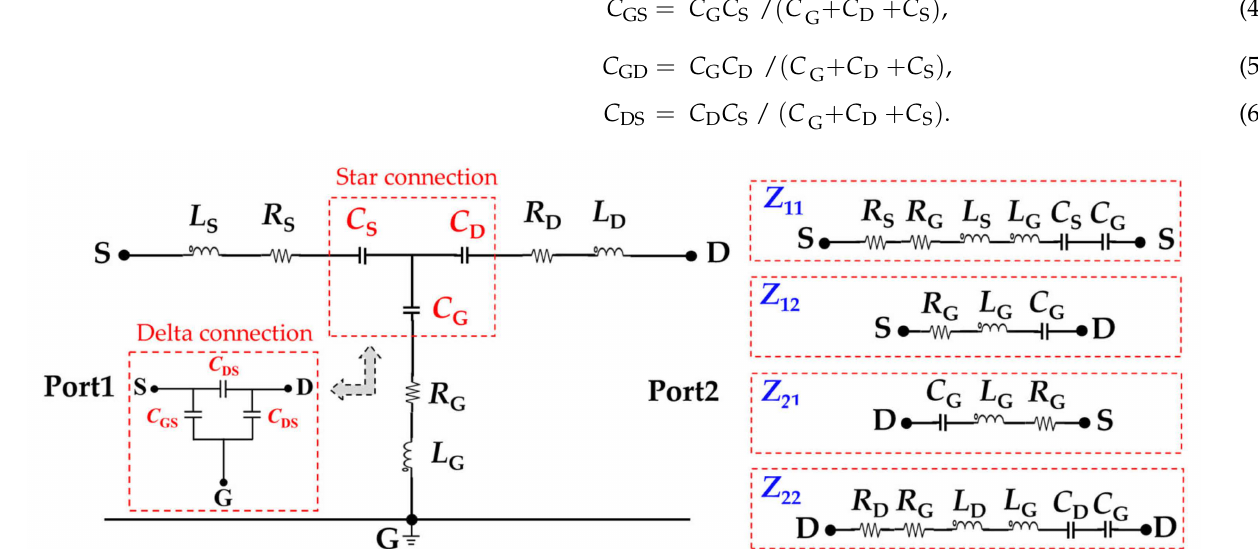
Figure 5. Two-port network of a MOSFET small-signal circuit model under zero biasing